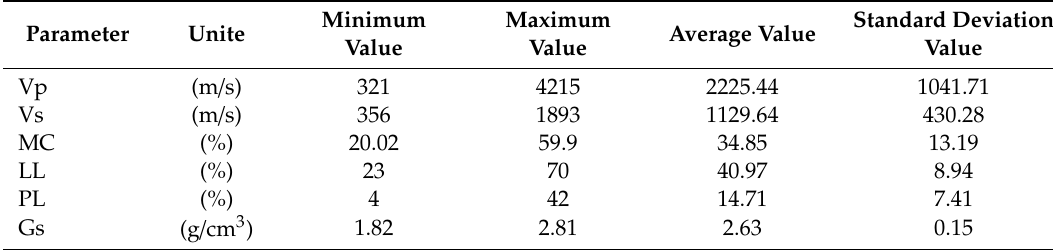
Table 2. The used input parameters for determining soil